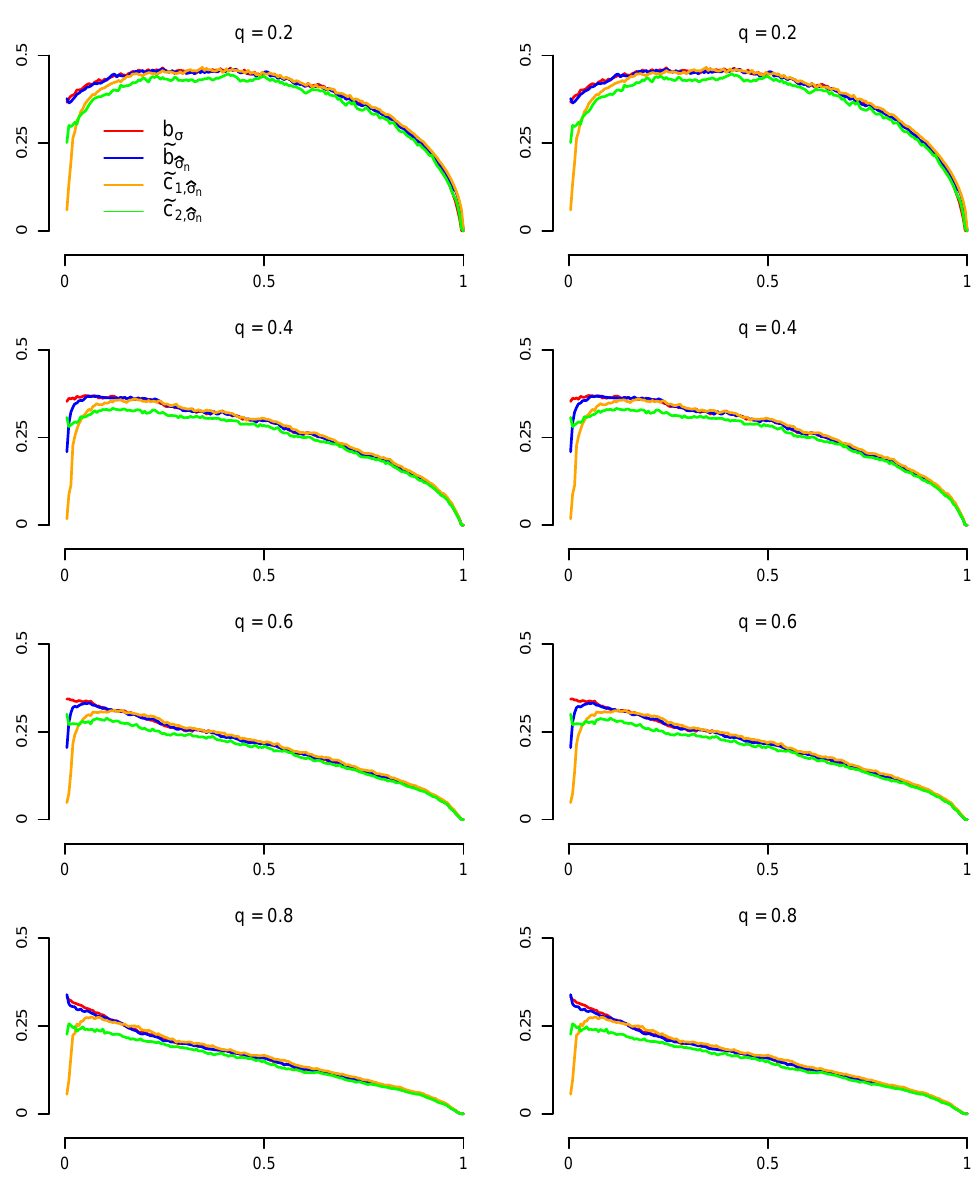
Figure 5. Mean of the payoff associated with: the true boundary b σ (red curve), the estimated boundary ˜ b (blue curve), the upper confidence curve ˜ c 1, (cid:98) σ n (green curve). The left column shows the low-frequency scenario ( r = 1), while the right one stands for the high-frequency scenario ( r = 25). We use σ = 1, T = 1, S = 10, X 0 = 10, and λ =